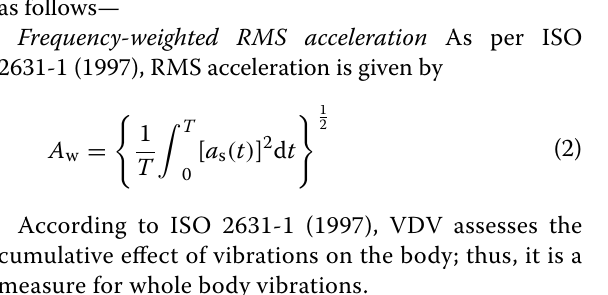
Control force is introduced as one of the objective func- tions to find the optimum control force to achieve ride comfort.